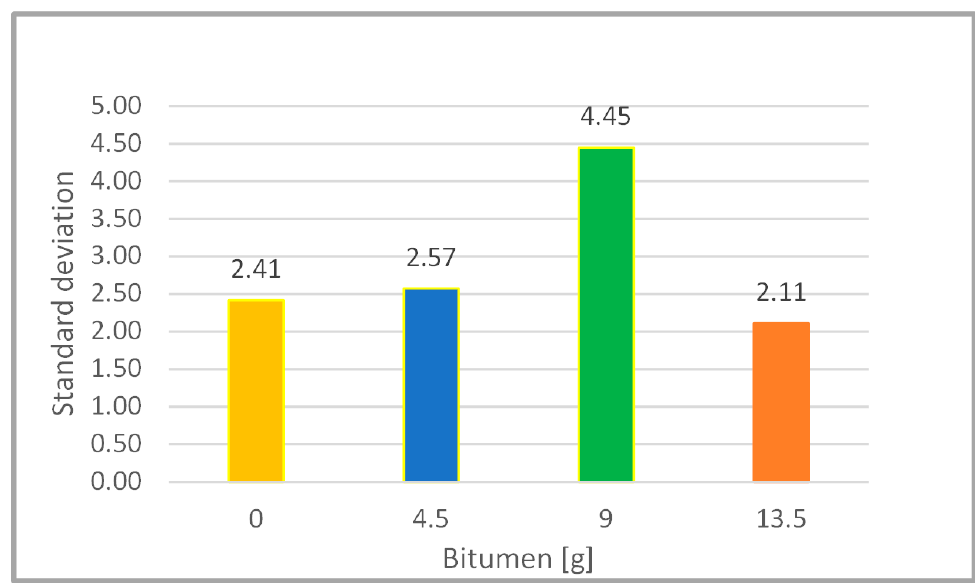
Figure 7. Standard deviation value of compression stress .